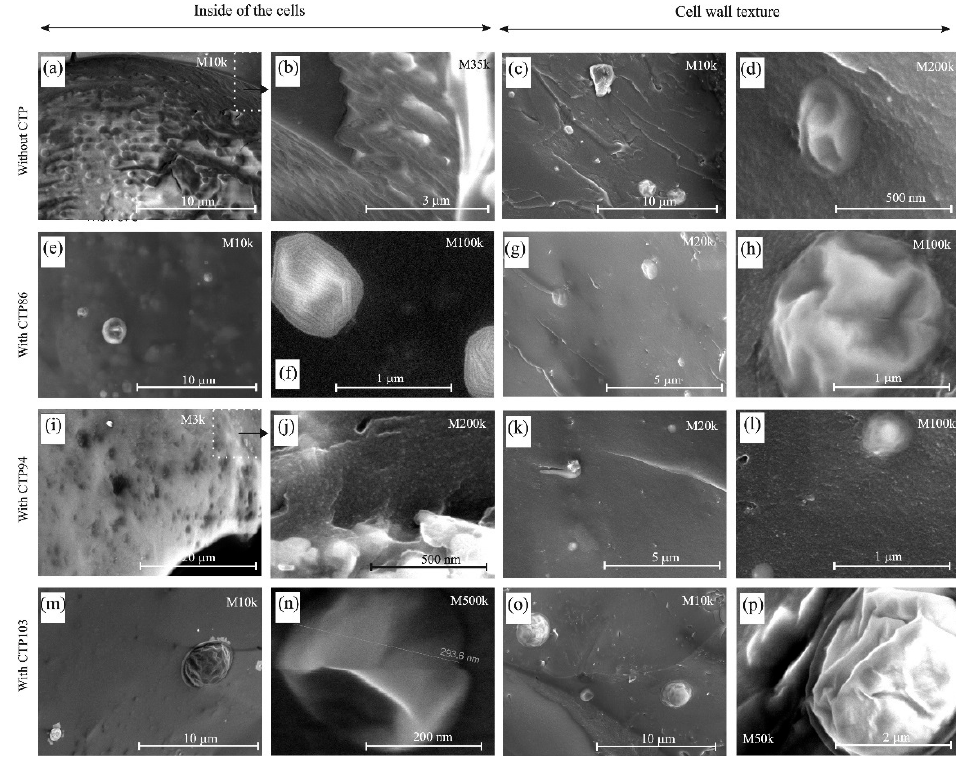
Figure 7. The SEM images of the material from the gas-saturated zone of coal and its blends with pitches. ( a , b ) insides of cells in gas-saturated zone of coal without CTPs, ( c , d ) cell wall textures in gas-saturated zone of coal without CTPs, ( e ) inside of cell in gas-saturated zone of coal with CTP86, ( f ) inside of cell in gas-saturated zone of coal with CTP86 with nano-objects, ( g , h ) cell wall textures in gas-saturated zone of coal with CTP86, ( i , j ) insides of cell in gas-saturated zone of coal with CTP94, ( k , l ) cell wall textures in gas-saturated zone of coal with CTP94, ( m ) inside of cell in gas-saturated zone of coal with CTP103, ( n ) inside of cell in gas-saturated zone of coal with CTP86 with nano-objects, ( o , p ) cell wall textures in gas-saturated zone of coal with CTP103.